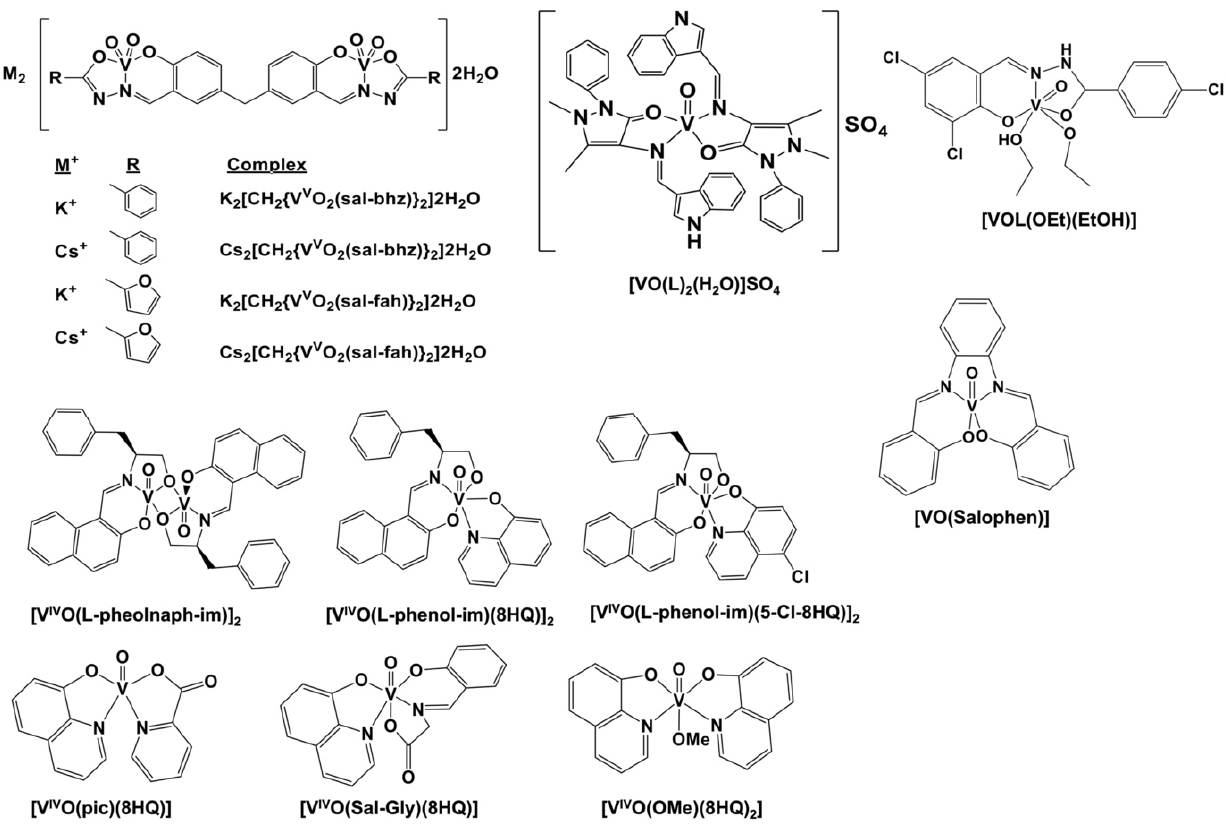
Figure 1. The structure of the classes of coordination complexes where activity of both the complex and ligand was investigated in bacteria [32,35–38].